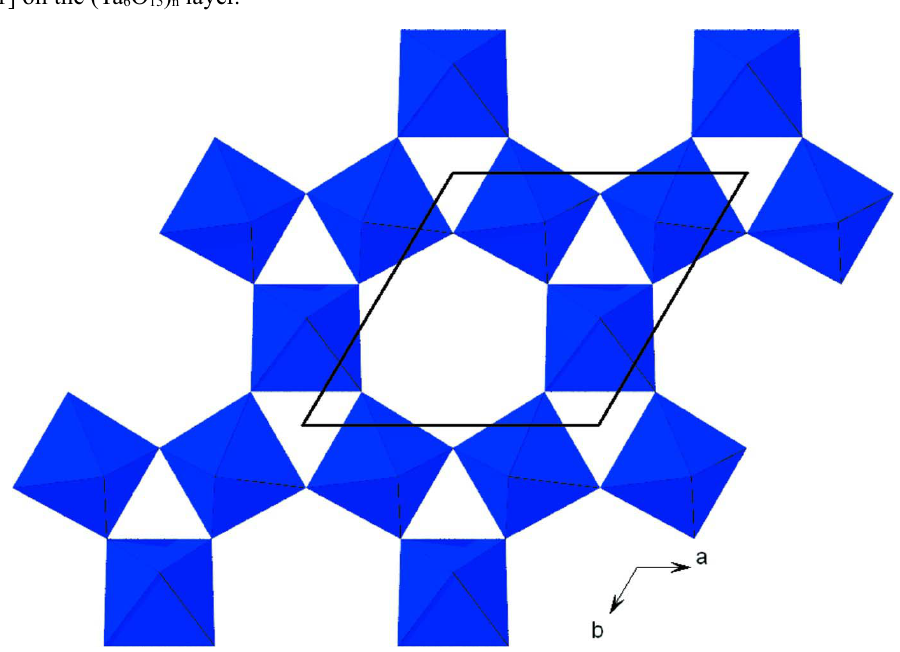
Figure 1 View along [001] on the (Ta